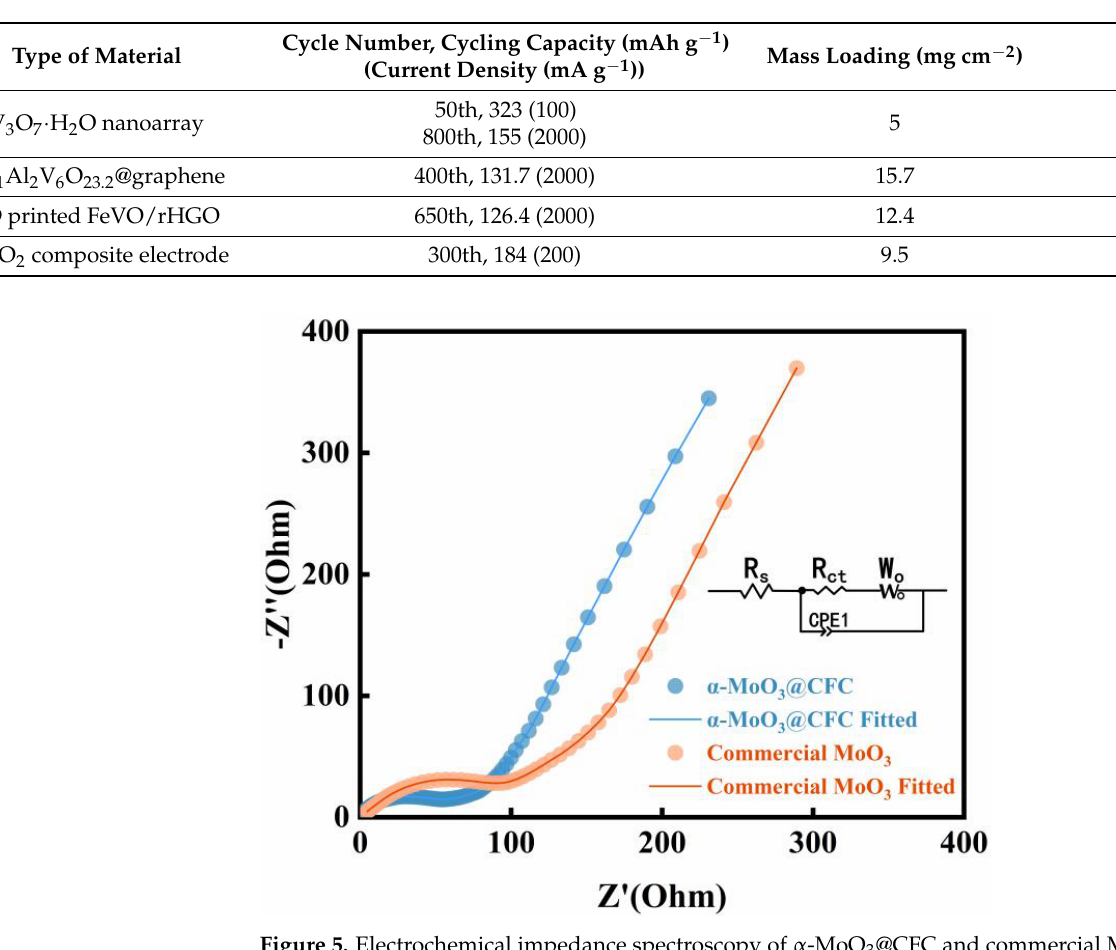
Figure S4: The ex-situ SEM images of α -MoO 3 @CFC (a) and commercial MoO 3 (b) after 20 cycles at